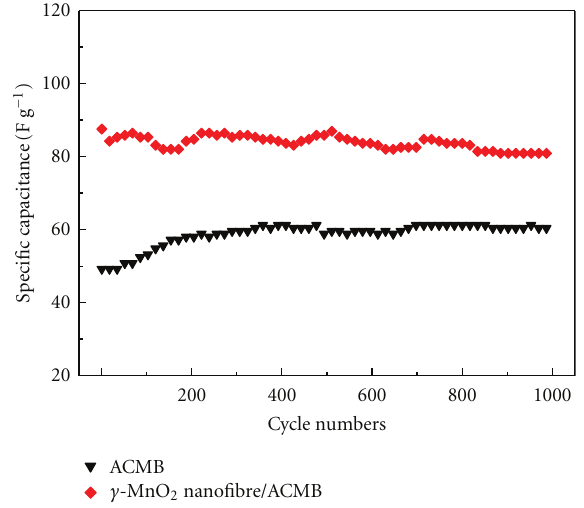
Figure 5: Cycle life curves of ACMB and γ -MnO 2 nanofibre/ACMB supercapacitors at a current density of 0.5 A g − 1